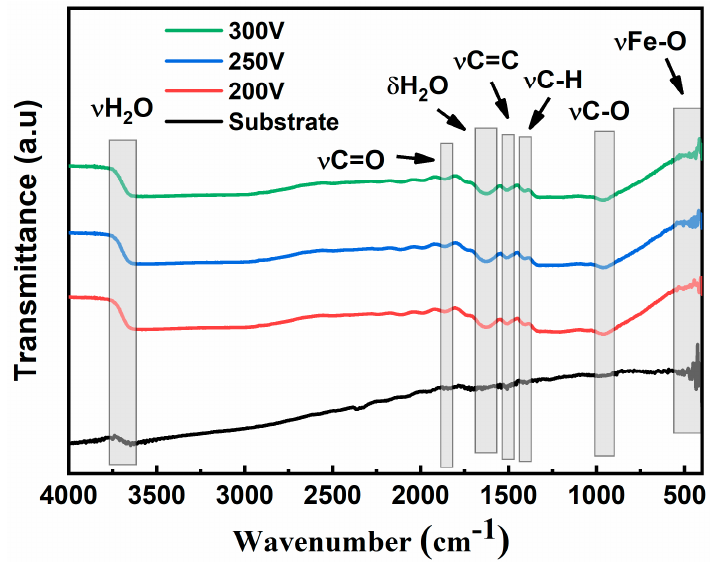
Figure 5. FTIR spectrums with the corresponding vibrational bands indicated in gray rectangles.